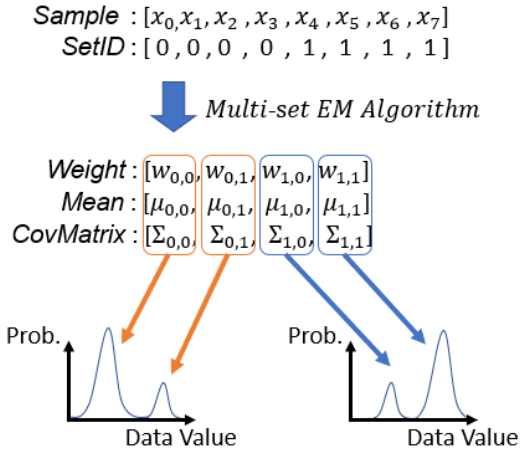
Figure 4. Examples of input and output arrays of running EM algorithm with two sets of samples when the number of Gaussian components ( K ) of each GMM is 2. In this example, Sample [ 0 ] to Sample [ 3 ] are all in the first set and Sample [ 4 ] to Sample [ 7 ] are in the second set. w i , j , µ i , j , and Σ i , j are the parameters of the j th Gaussian component in the i th